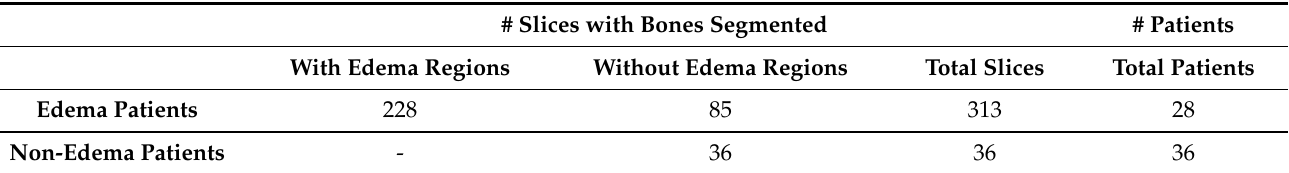
Table 1. UHCSJ Dataset distribution of the number of patients and slices per class. # Slices with Bones Segmented # Patients With Edema Regions Without Edema Regions Total Slices Total Patients Edema Patients 228 85 313